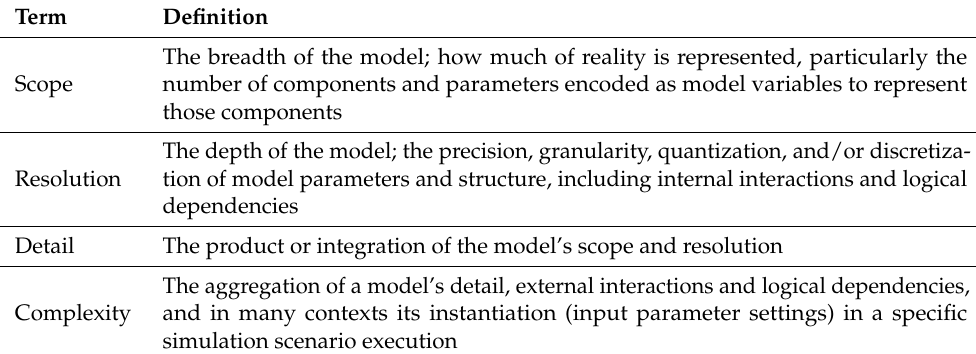
Table 1. New definitions of simulation model complexity and related terms synthesized from Zeigler, Davis, and others.